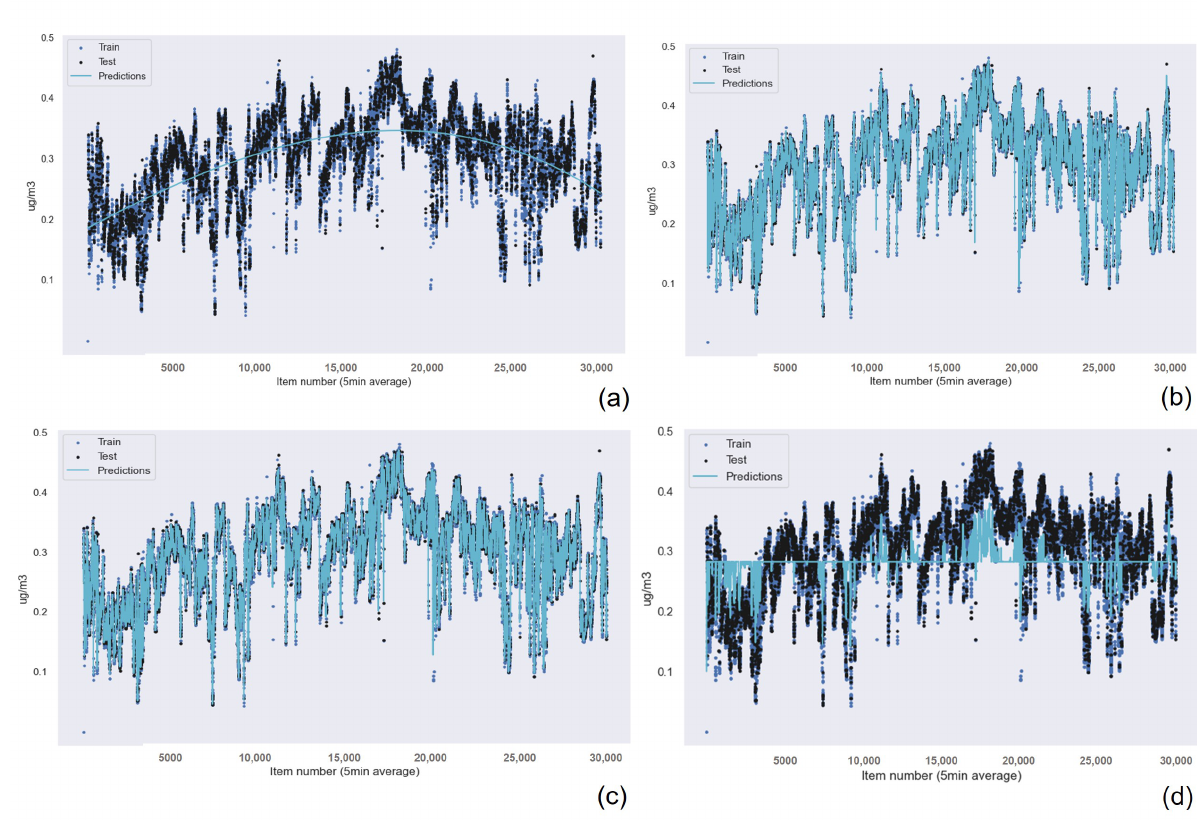
Figure A4. CO results for ( a ) Linear Regression ( b ) Random Forest Regression ( c ) KNN and ( d ) Sup- port Vector Machine.